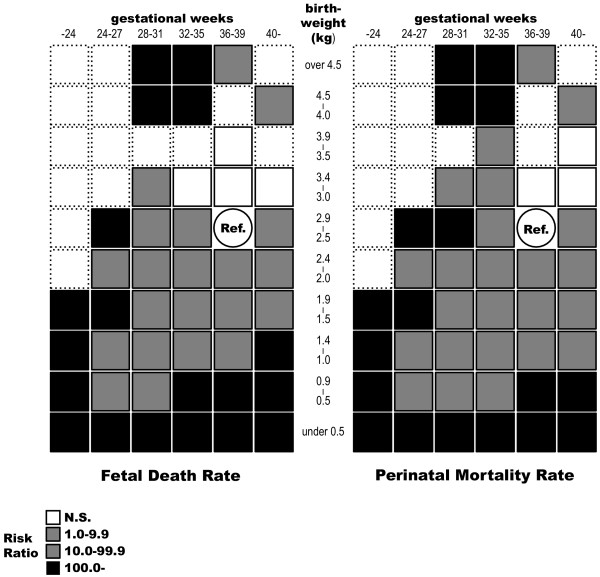
Twin/lowest twin risk ratio. The risk ratio for each birth weight and gestational week category is shown. Birth weight and gestational weeks category for the lowest mortality is a reference with a risk ratio of 1.0.